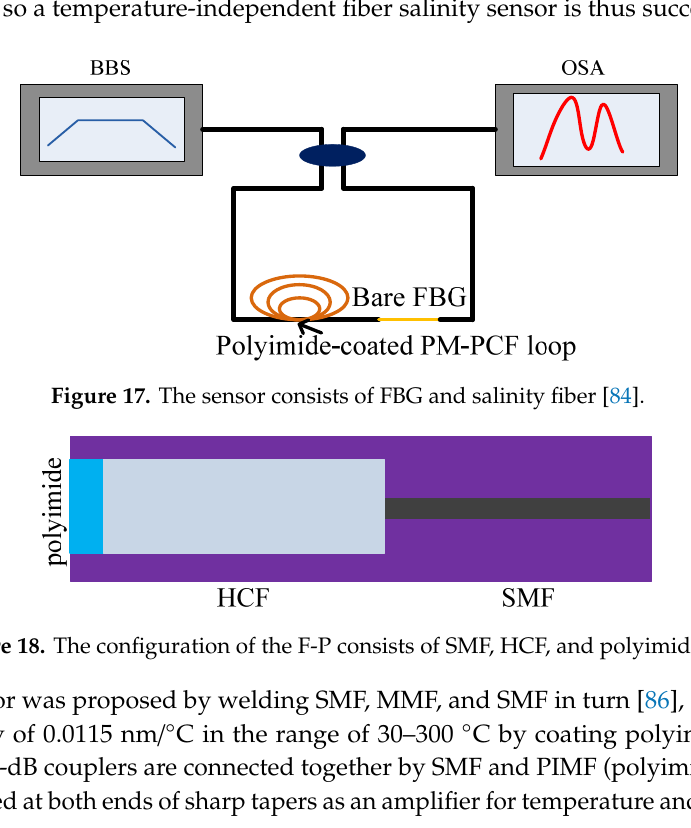
Figure 18. The configuration of the F-P consists of SMF, HCF, and polyimide [85].